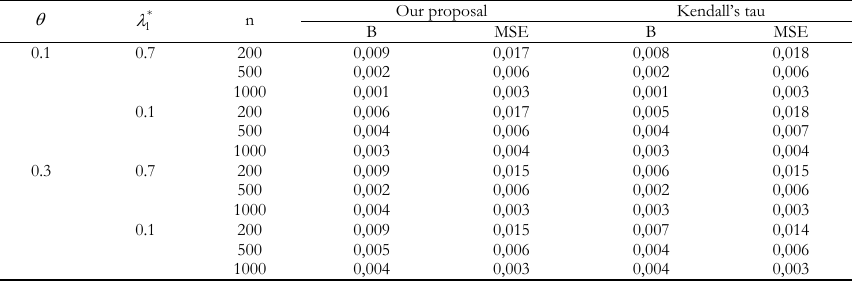
Comparison between our proposed estimators and the estimator based on Kenfdall’s tau